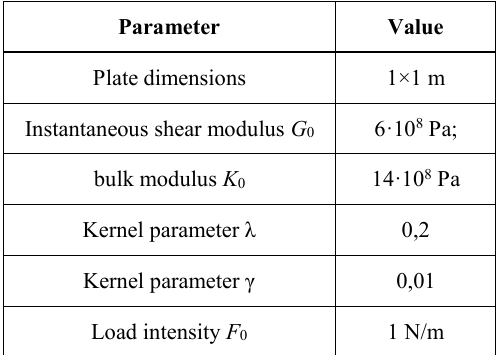
Table 1. The numerical model